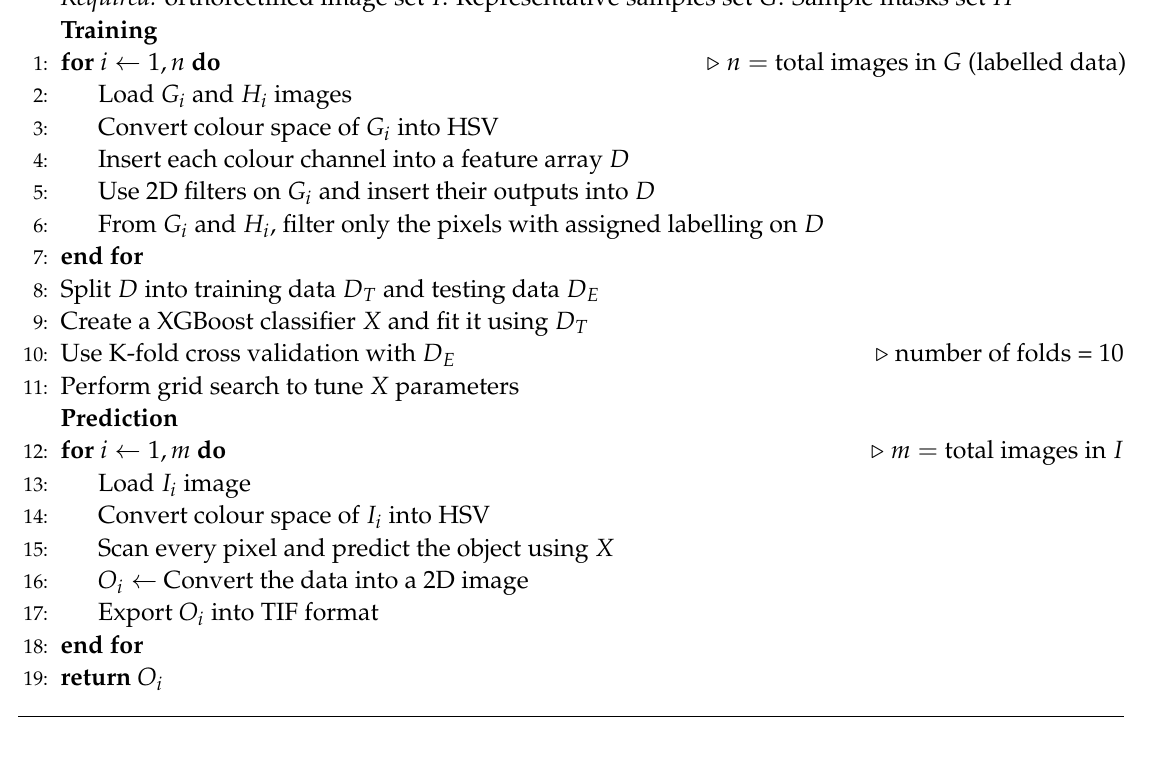
Algorithm 1 Detection and segmentation of invasive grasses using high-resolution RGB images. Required: orthorectified image set I . Representative samples set G . Sample masks set H